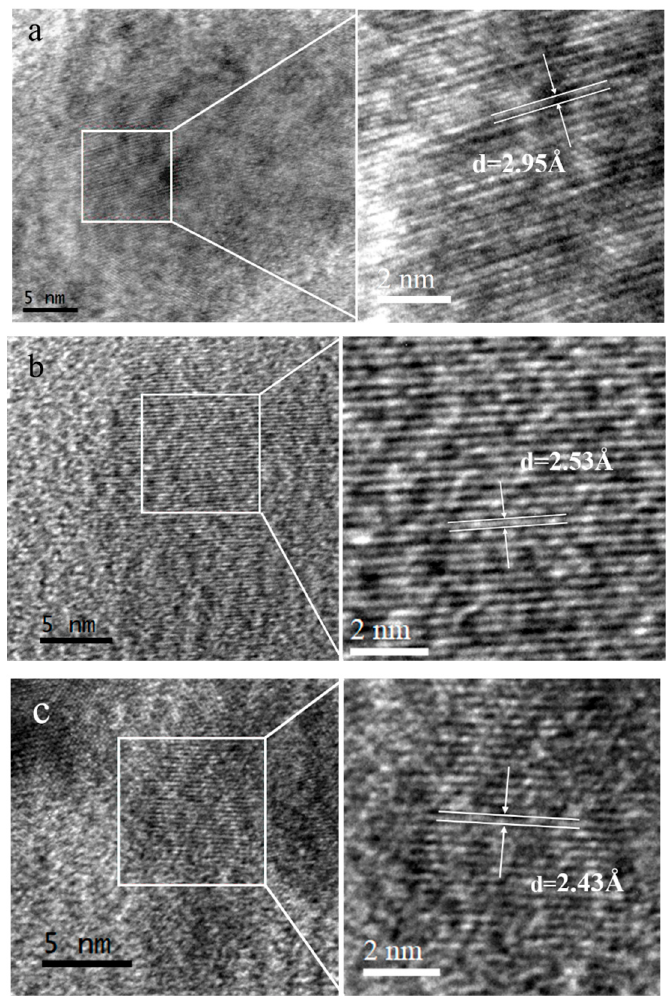
Figure 7. High-resolution transmission electron microscopy (HRTEM) analysis of the nanoparticles cultured in media 1 # ( a ), 2 # ( b ), and 3 # ( c ).